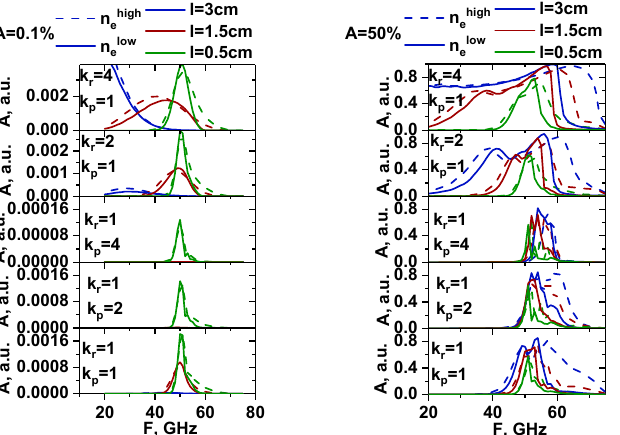
Figure 35. The dependency of the signal amplitude on different probing frequencies for the high- density profile from Figure 1 (dashed lines) and low-density profile from Figure 34 (regular lines): ( left ) filaments with an amplitude of 0.1% of density at cutoff of the probing wave 48 GHz where the filament was positioned; ( right ) filament with an amplitude of 50%. The blue lines correspond to 3 cm diameter filaments, the red lines correspond to 1.5 cm, and the green lines correspond to 0.5 cm. Different proportions of stretching of the filaments are presented in the figure.